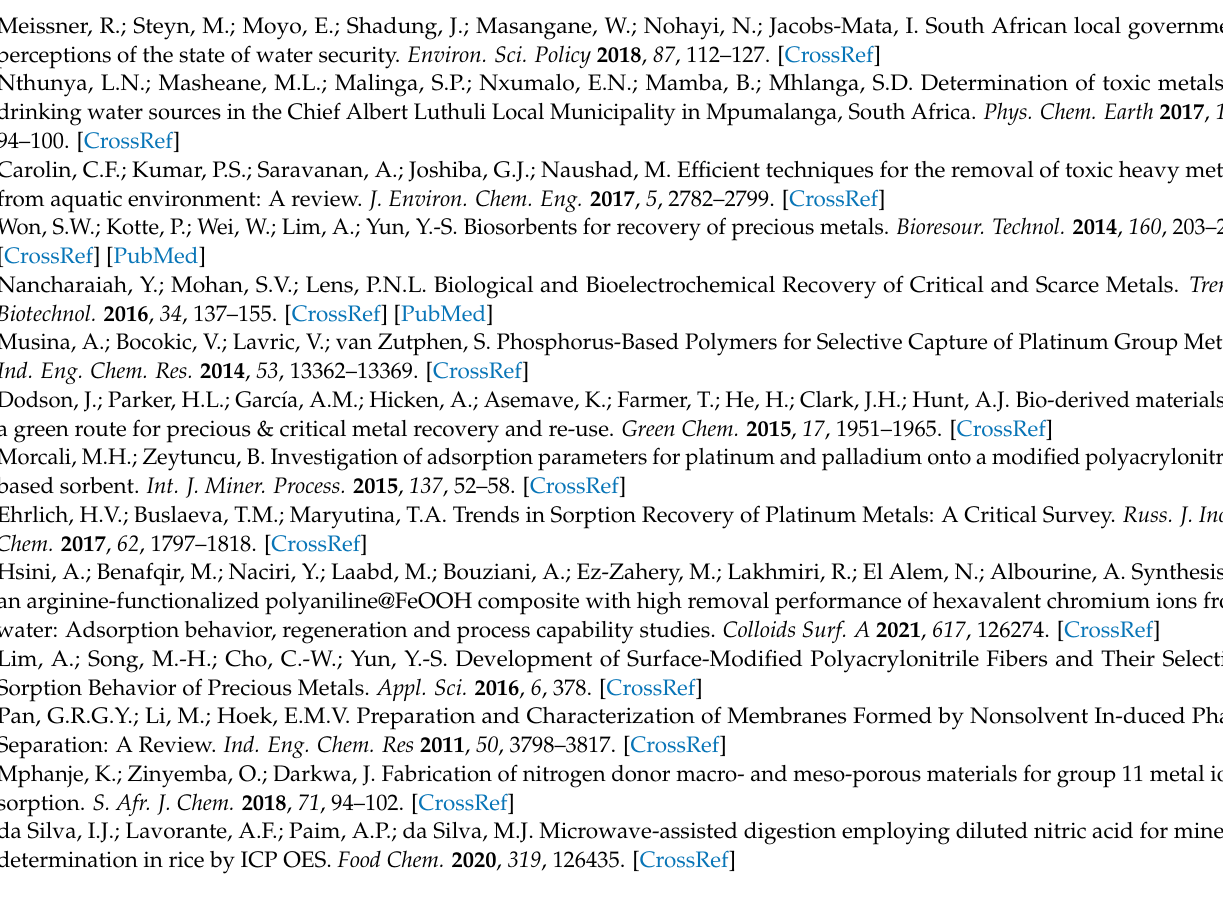
Figure S2: BET adsorption isotherm for crushed unfabricated neat PAN, Figure S3: BET adsorption isotherm of crushed composite polymer monoliths, Figure S4: TGA curve representing the weight loss (%) of unfabricated raw PAN, mesoporous neat PAN and mesoporous composite polymer monoliths over a temperature range of 25 ◦ C to 650 ◦